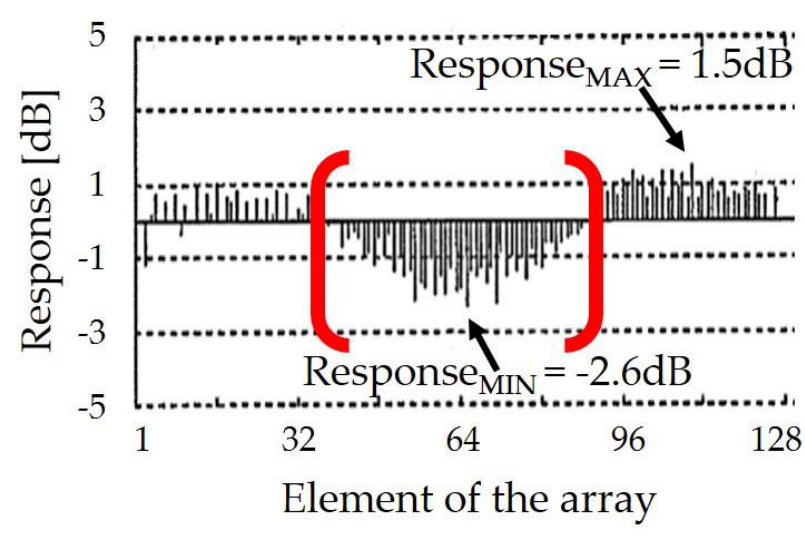
Figure 8. Measurement of the response (electroacoustic characterization) for all 128 array elements.